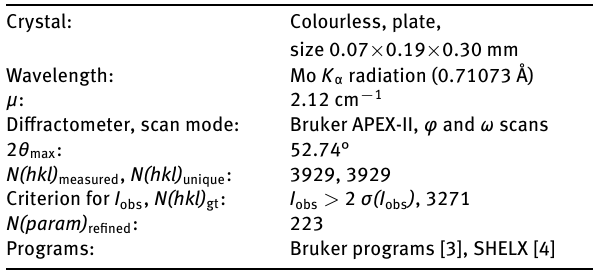
Table 2: Fractional atomic coordinates and isotropic or